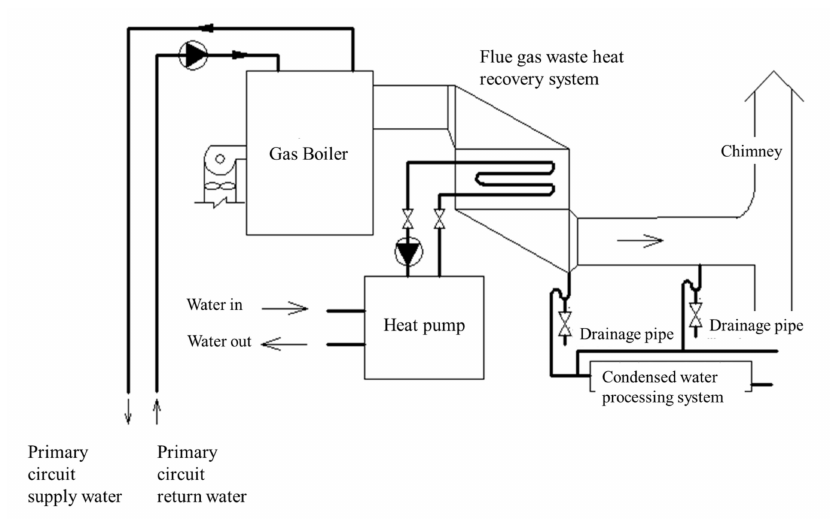
Figure 1. System diagram of case 1 [5].